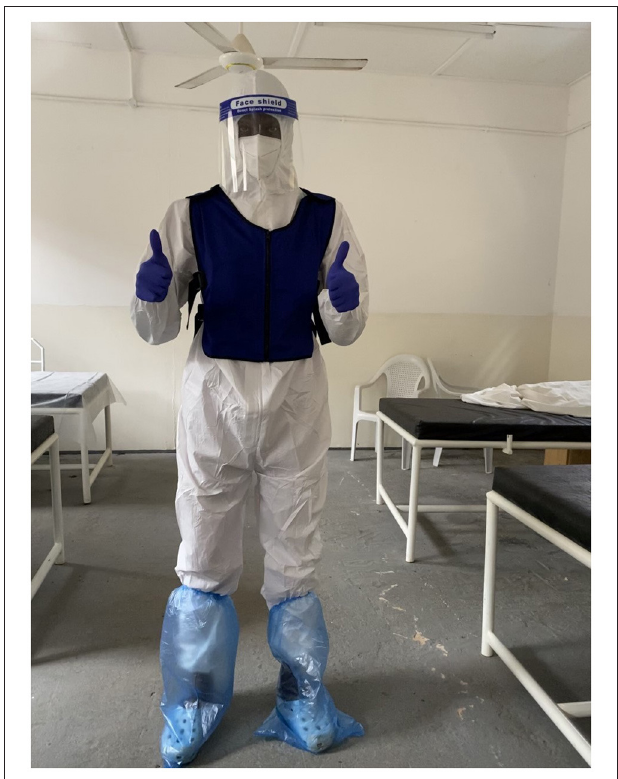
FIGURE 1 | A participant in full PPE with ice